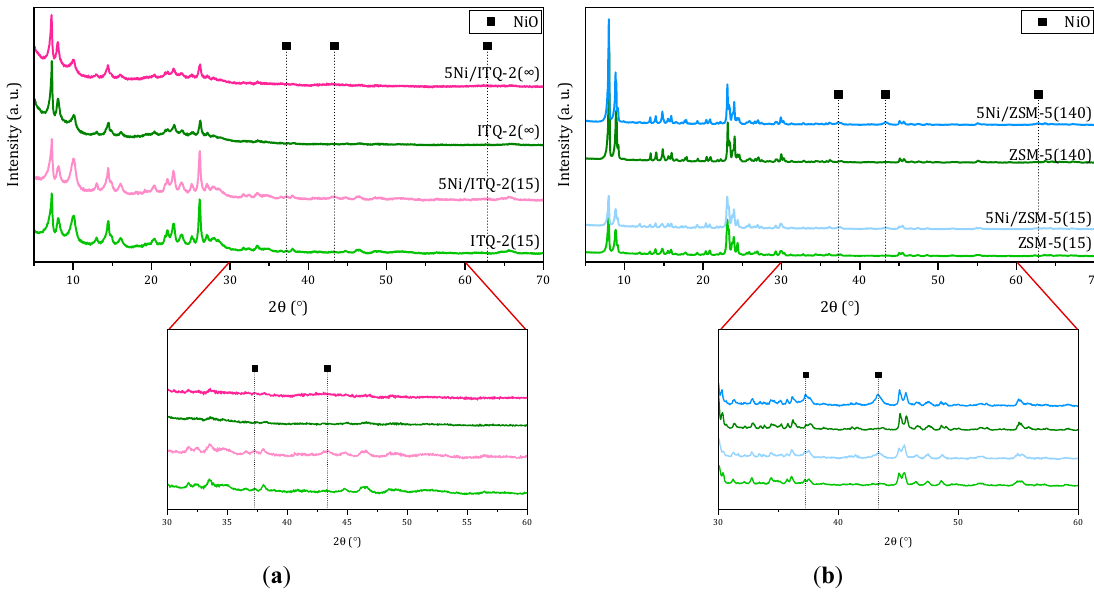
Figure 1. X-ray diffraction (XRD) patterns of the supports and the corresponding 5 wt.% Ni catalysts supported on ( a ) ITQ-2; (b) ZSM-5 with different Si/Al ratios.